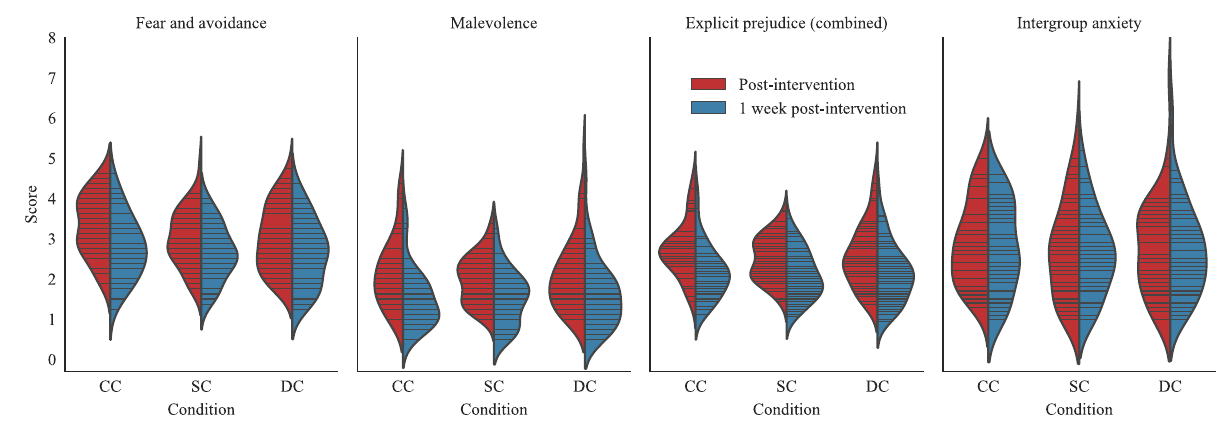
Figure 4. Explicit prejudice scores per condition, for each of the explicit measures, after the intervention vs. at the 1-week follow-up survey. The lines inside the plots represent the underlying data points for each of the